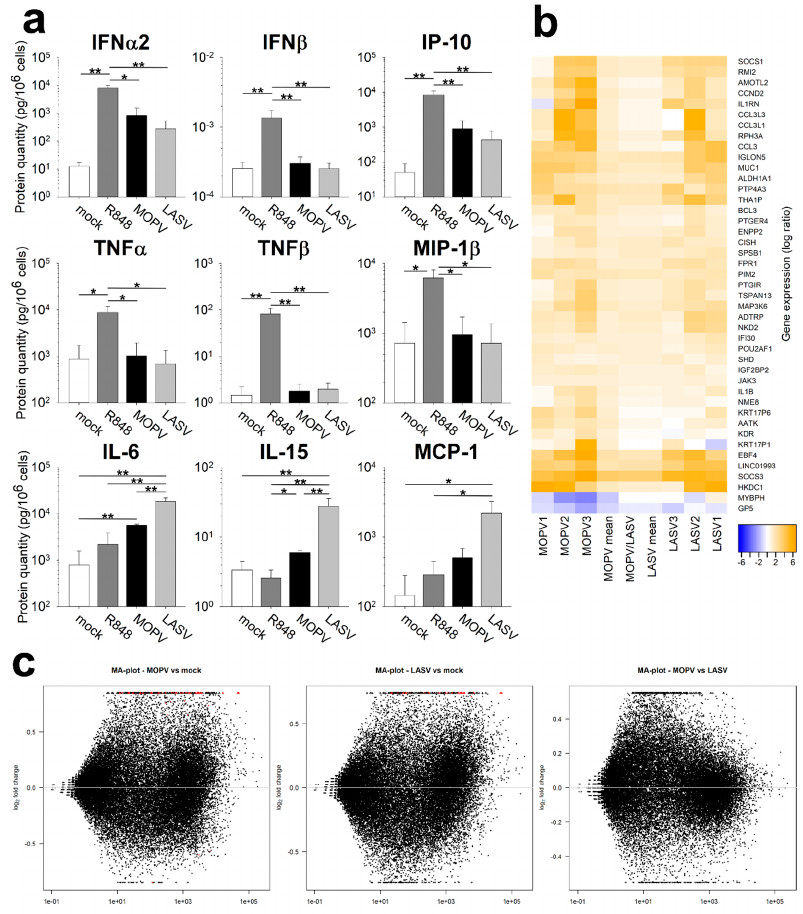
Figure 3. MOPV- and LASV-infected pDCs show different patterns of activation. ( a ) pDCs were cultured for 16 h with culture medium (mock), R848 (1 µg/mL), MOPV, or LASV (MOI = 2). Protein levels were quantified using the Luminex assay. Data are presented as the means and SEM of five independent experiments. Wilcoxon tests were performed, and differences are significant for p < 0.05 (*) or p < 0.01 (**). ( b , c ) pDCs were cultured for 12 h in culture medium (mock), MOPV, or LASV (MOI = 1). Cellular mRNA from three independent experiments was quantified by poly-A amplification and next-generation sequencing. ( b ) Data show the differential expression of genes in MOPV relative to LASV (MOPV/LASV) infected cells or in MOPV or LASV infected cells relative to mock (1, 2, 3, and mean). Genes shown in this figure displayed significant differences of expression (adjusted p < 0.05). ( c ) MA plots for all pairwise comparison of data sets (MOPV/mock, LASV/mock and MOPV/LASV). Red dots indicate significantly different genes between the two conditions. Triangles correspond to features having a too low/high fold change to be displayed on the